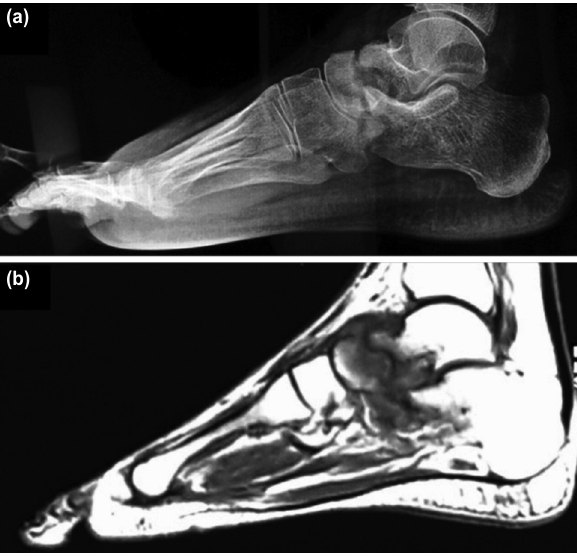
(a) Radiograph showing bony destruction of head of Fig. 4: talus. (b) MRI (T1W) of same